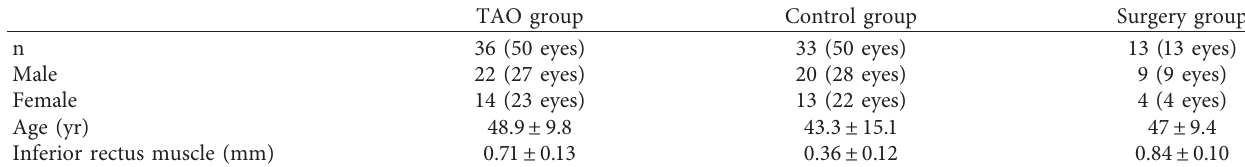
Table 1: Demographic data.